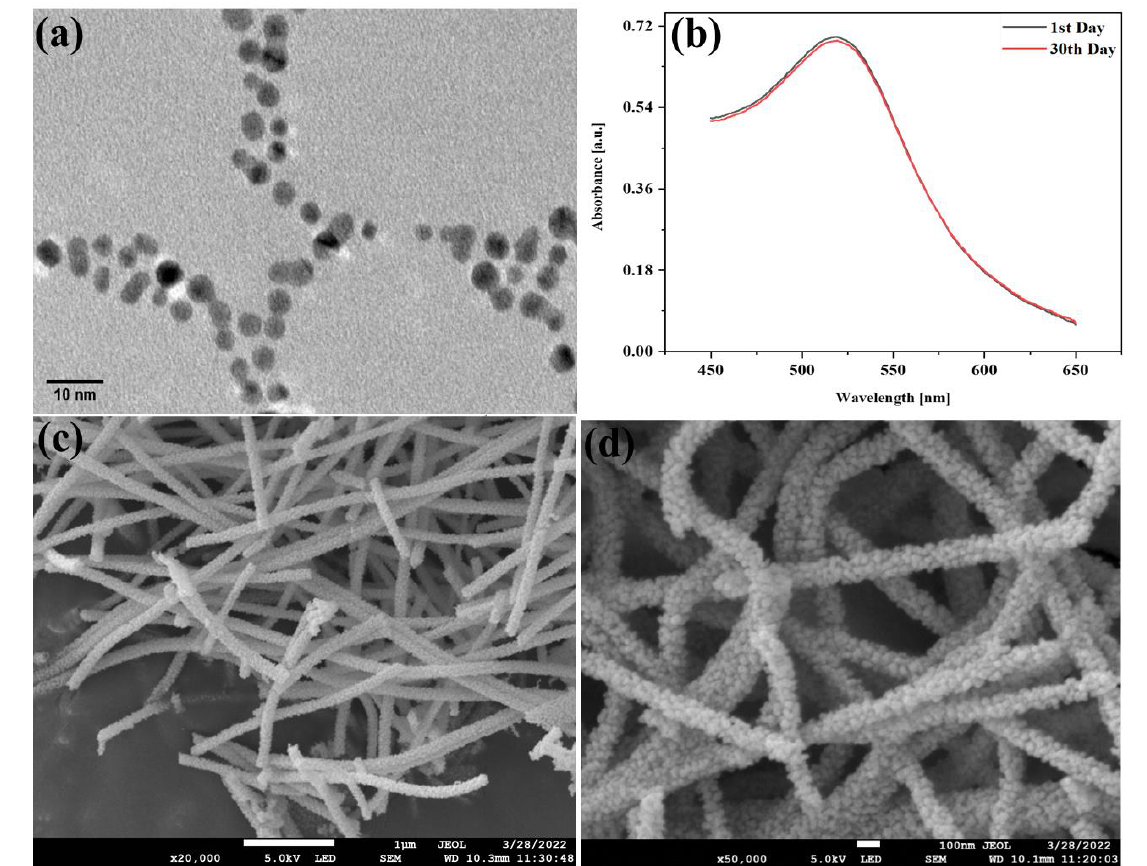
Figure 1. ( a ) TEM image of Au NPs at 150,000× magnifications; ( b ) UV-Vis analysis of Au NPs; FESEM images of SnO 2 nanofibers. ( c ) ×20,000 and ( d ) ×50,000 magnifications.